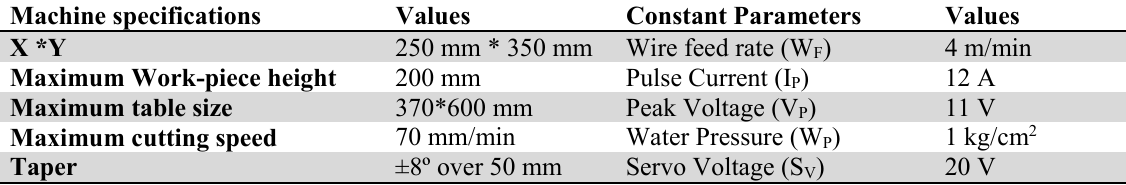
Machine specifications and constant parameters